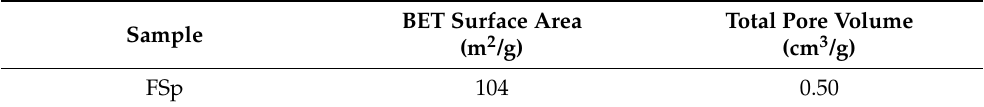
Figure 4. Physisorption isotherm of FSp. Table 2. Information on FSp analysis.